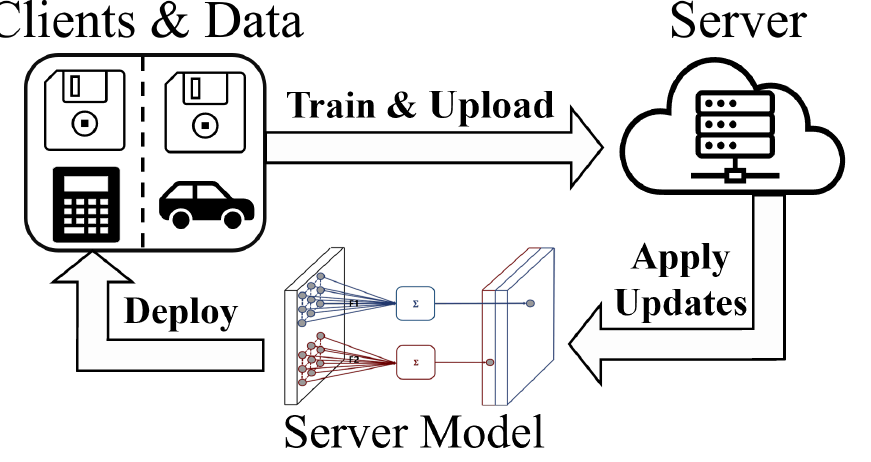
Figure 1. General procedure of federated